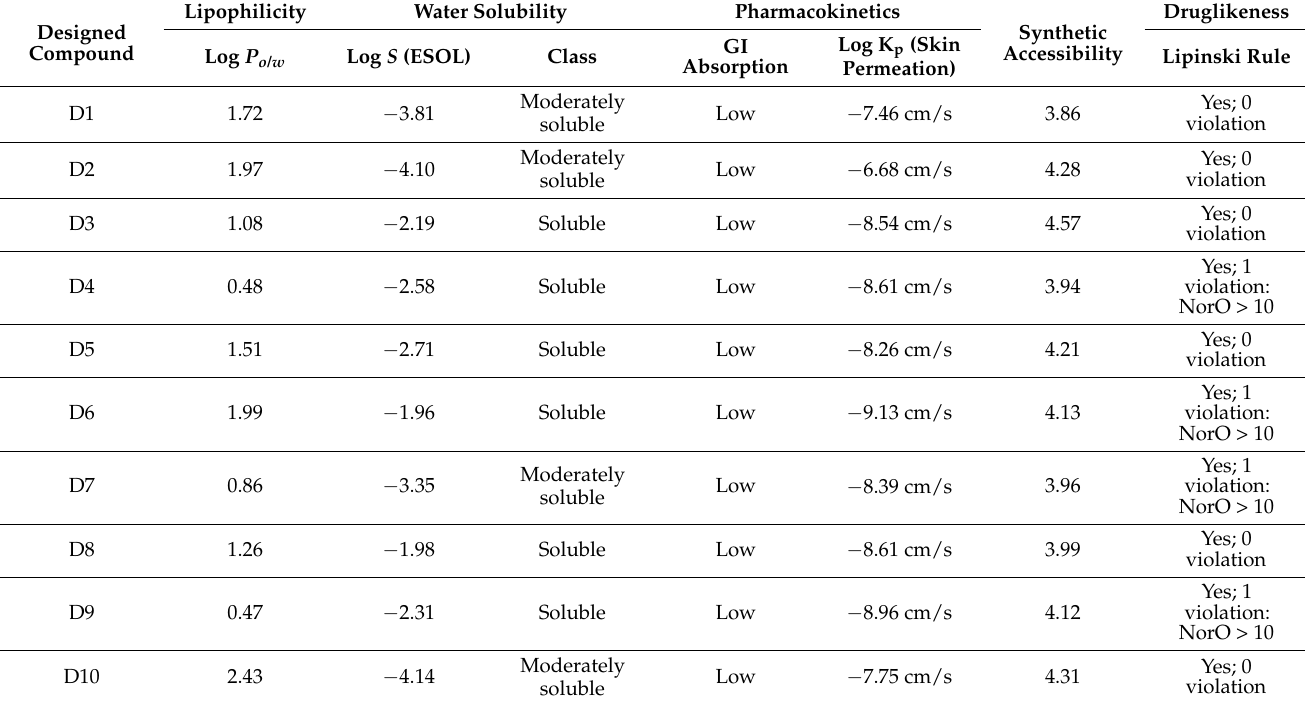
Table 3. In silico (absorption, distribution, metabolism, and excretion (ADME) prediction and synthetic accessibility values of new designed RET kinase antagonists. Designed